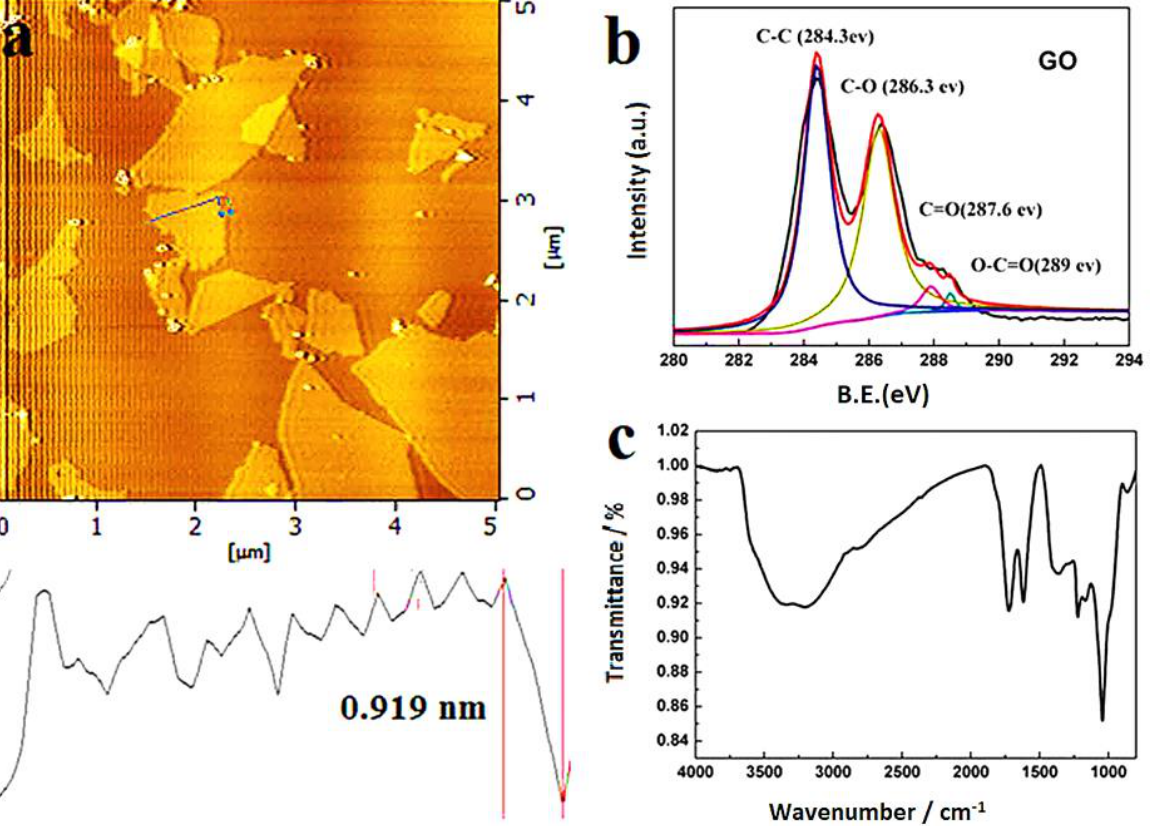
Figure 2. ( a ) AFM image and height profile of GO, ( b ) XPS spectra of GO, and ( c ) FTIR spectra of GO [58]. (Adapted with permission from ref. [58]. Copyright 2016 Taylor and Francis online.)